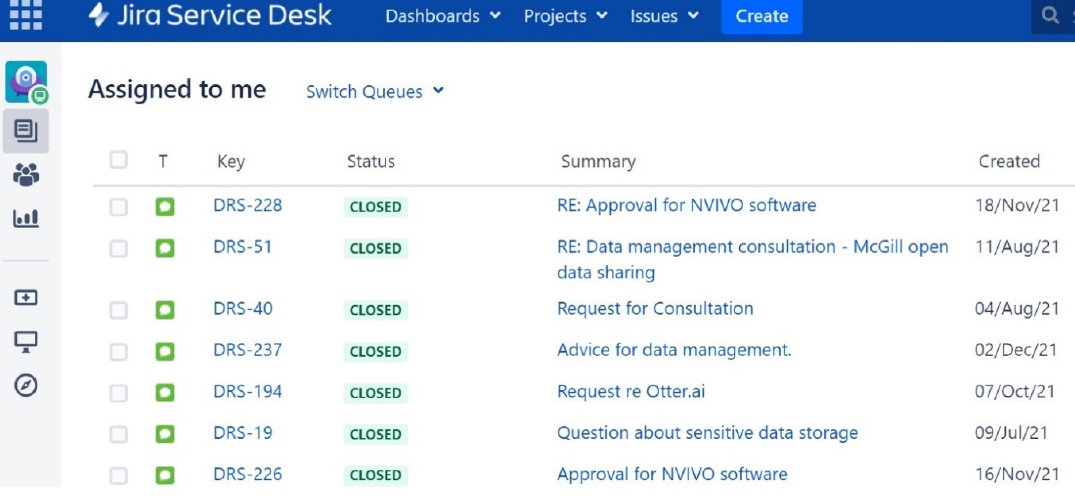
Figure 1 : Digital Research Services Jira Service Desk Ticketing System dashboard. This image shows the ticketing queue for tickets assigned to one team member. Note: this image has been cropped for privacy considerations.